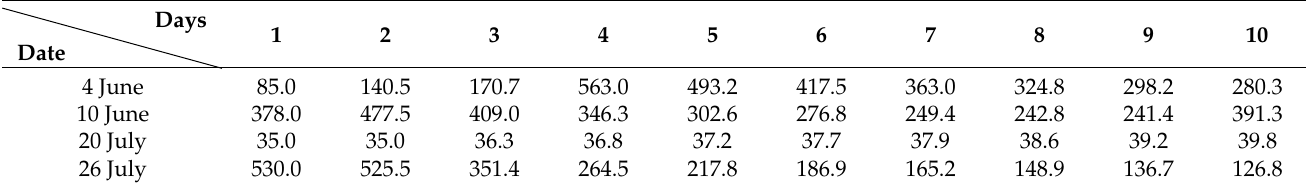
Table 1. Mean turbidity (in units of NTU) averaged over different numbers of days.